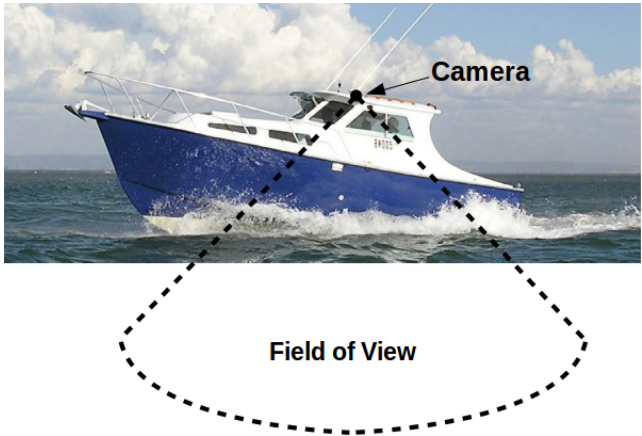
Figure 1. Proposed camera location on the